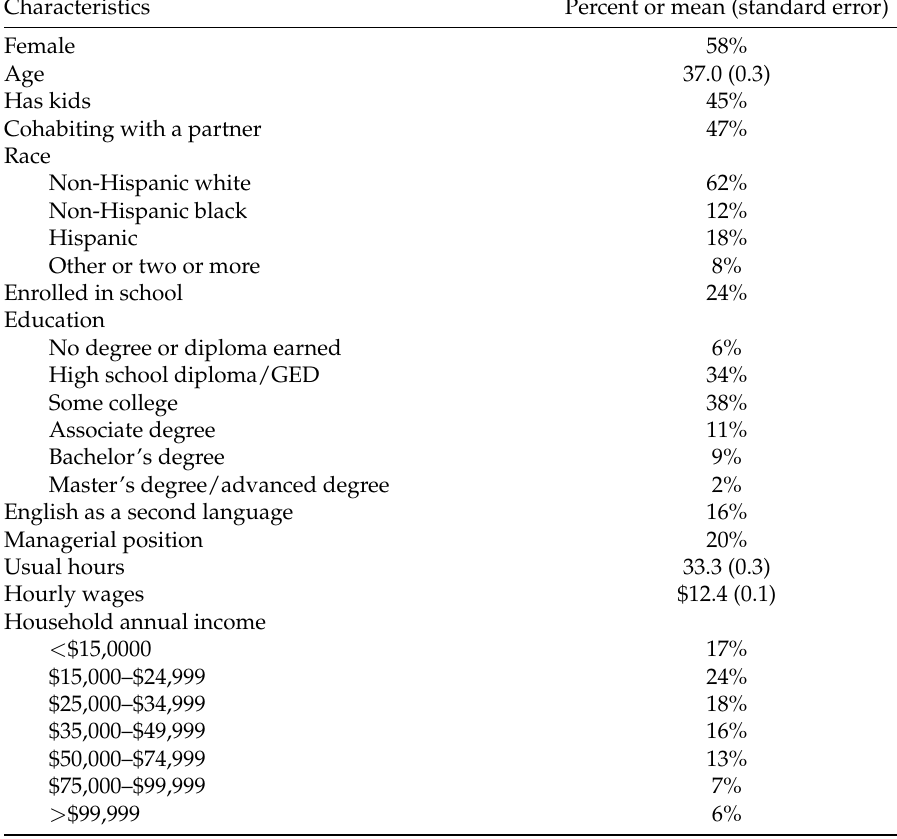
Table 1: Descriptive statistics for the sample (weighted)